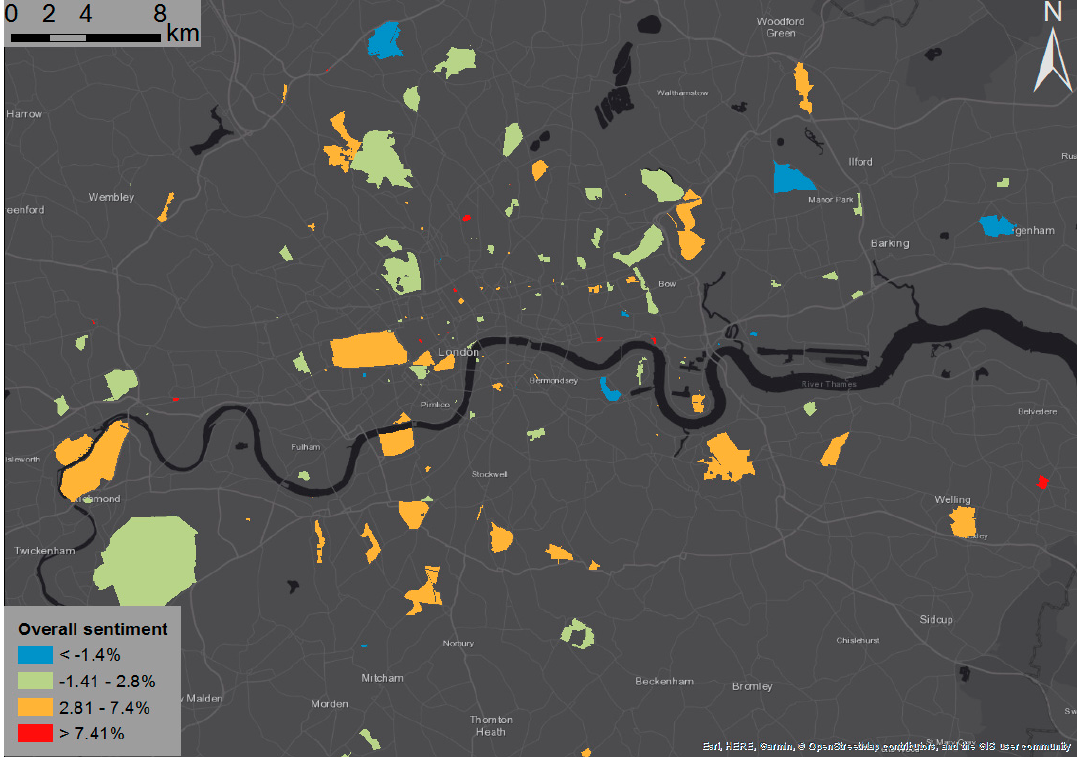
Figure 12. Overall sentiment scores in parks with at least 100 tweets.